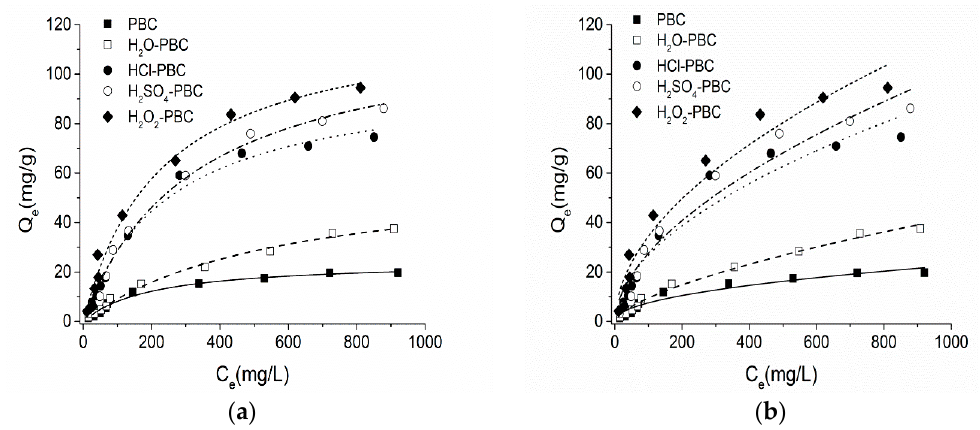
Figure 6. Adsorption isotherms of NH 4+ -N on the biochar samples as well as modeling with the Langmuir ( a ) and Freundlich ( b ) models. Table 2. Fitting parameters for the Langmuir and Freundlich isotherms of NH 4+ -N adsorption in an aqueous solution on the differently treated biochar.